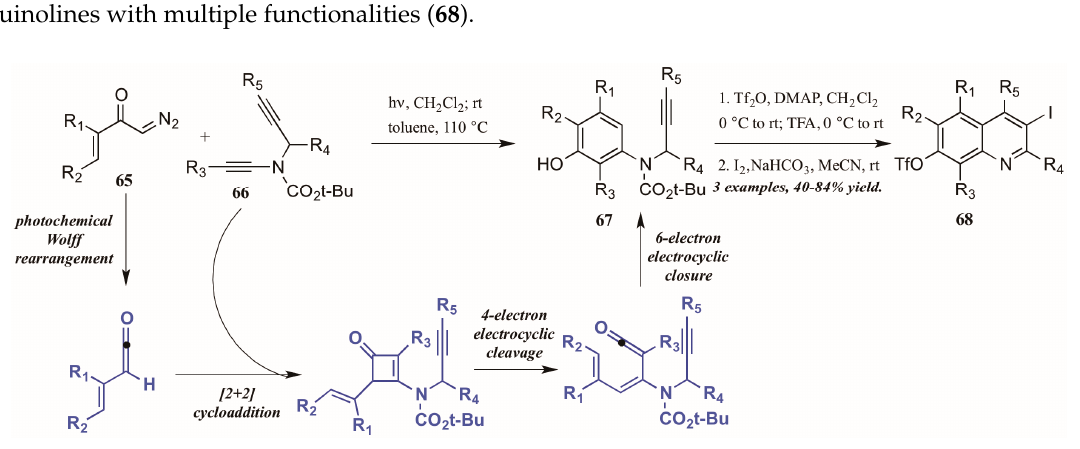
Figure 32. Electrophilic cyclization of aryl amides with sulfanyl ynamides. Figure 33. Oxidative cyclization of aryl diamines with carbonyl compounds.